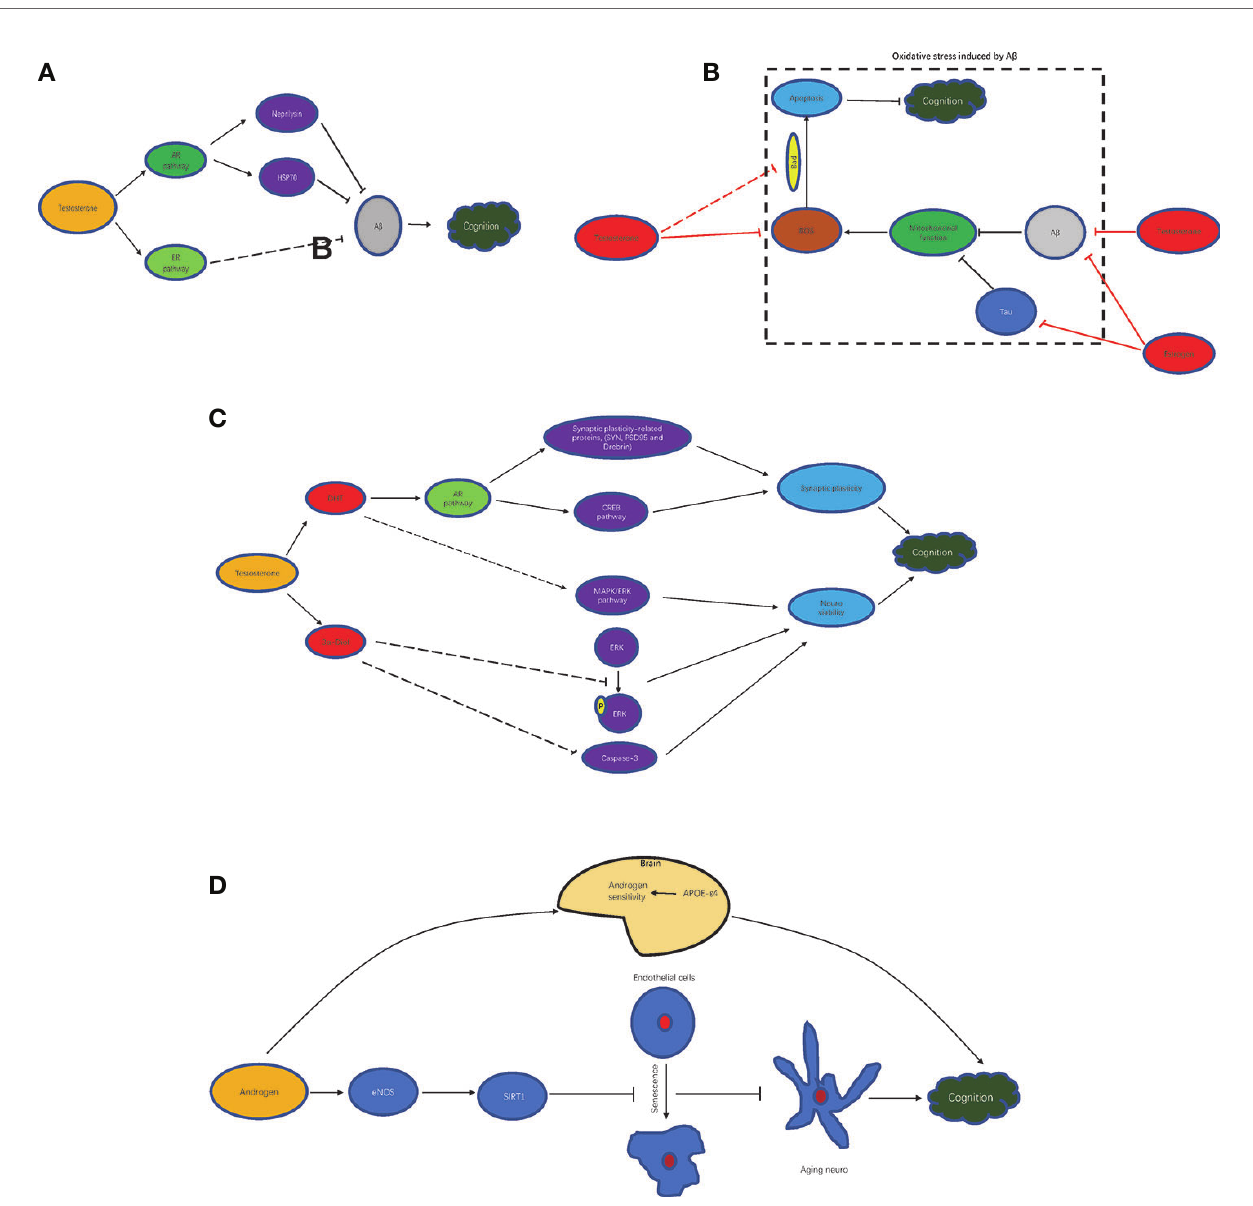
FIGURE 1 | Mechanism of androgen improving cognitive impairment. (A) androgen and A b clearance; (B) androgen and oxidative stress inhibition; (C) androgen metabolites and cognition improvement; (D) androgen-related other